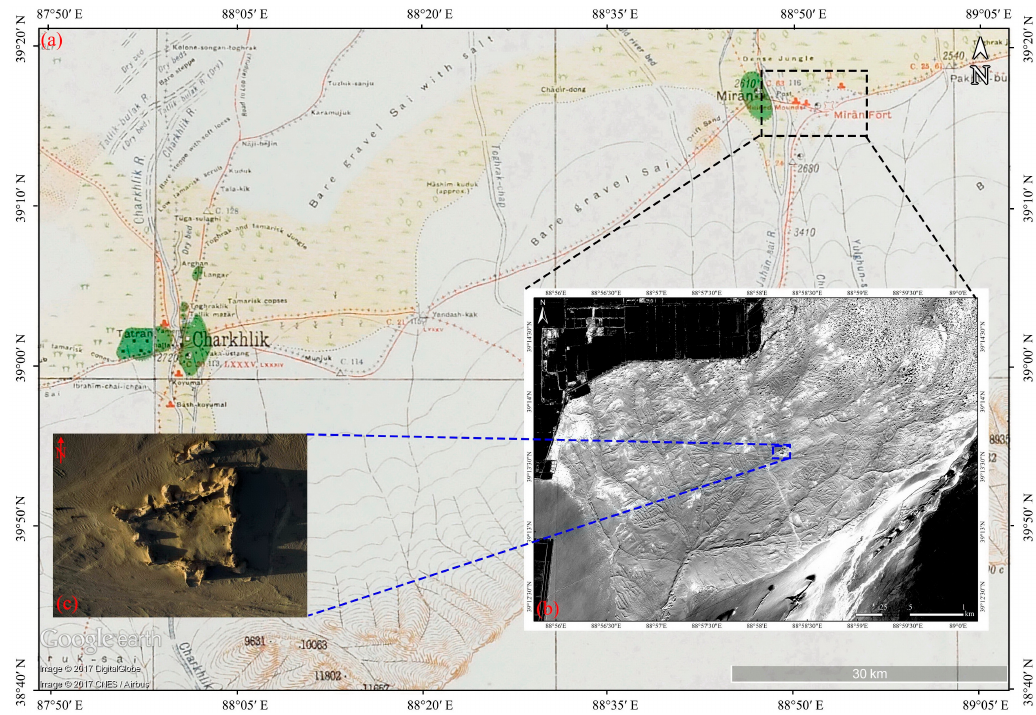
Figure 2. ( a ) The locations of the Miran site and ancient Charkhlik in Stein’s archaeological map, which can be downloaded from http://dsr.nii.ac.jp/; ( b ) the conservation area of the Miran site where LATTICs can be seen in the GF-1 PAN image; and ( c ) Miran Fort.